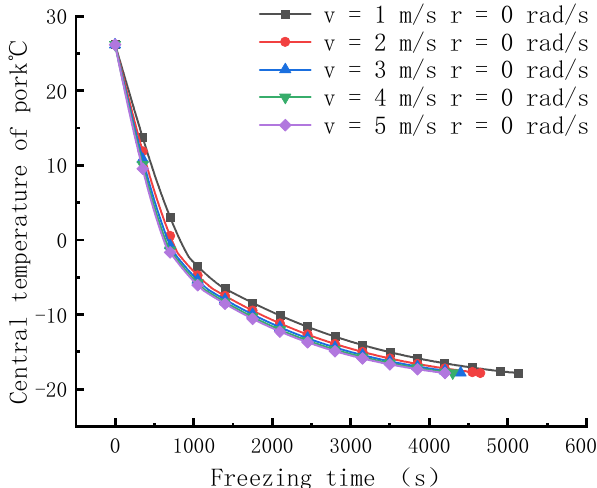
Figure 6. Pork center temperature curve with time. Table 6. Flow rate and freezing rate of refrigerant carrier. Reprinted with permission from Ref. [21]. 2012, Deng, M.; Zhu, Z. More details on “Copyright and Licensing” are available via the fol ‐ lowing link: cnki.net.